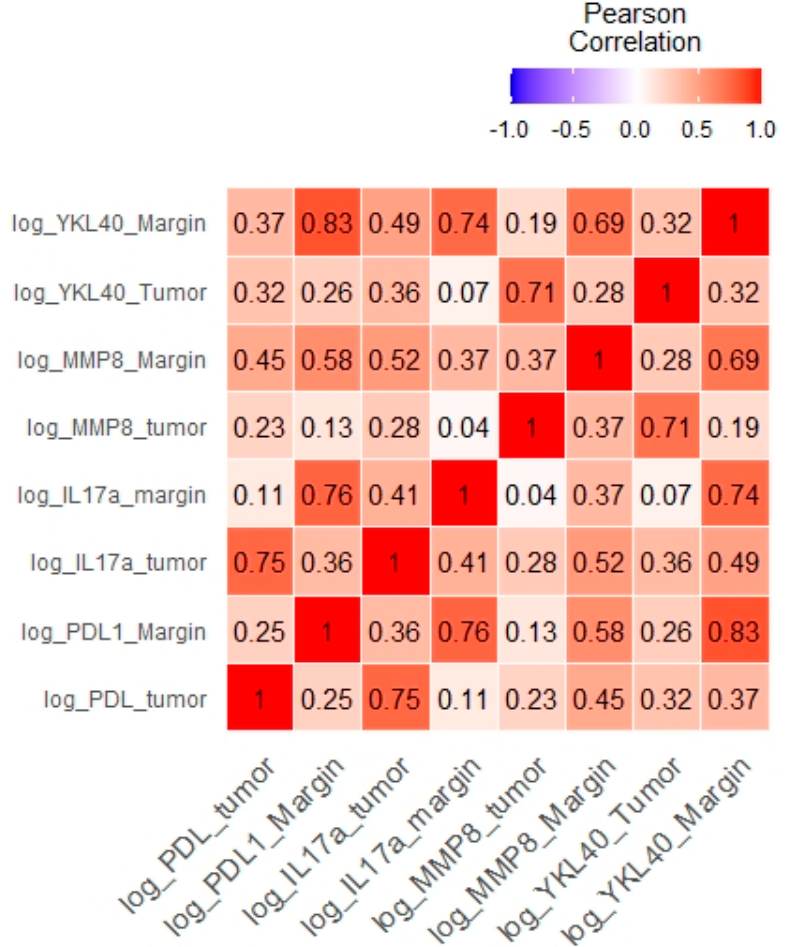
and IL-17 (R = 0.36, p = 0.026), YKL-40 and MMP-8 (R = 0.71, p < 0.0001), and PD-L1 and IL-17 (R = 0.75, p < 0.0001).